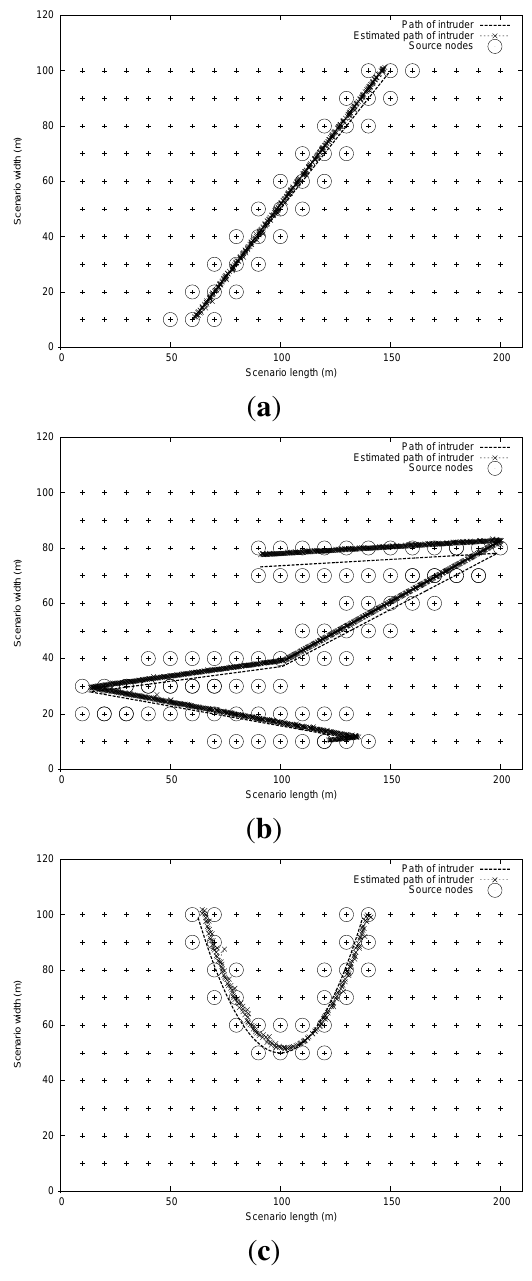
Figure 2. Illustration of the intruder tracking accuracy for different mobility patterns: ( a ) straight, ( b ) random and ( c )